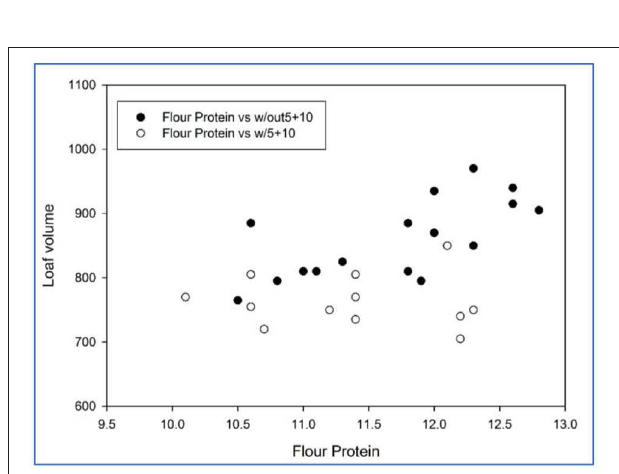
FIGURE 2 | Bread loaf volume of soft durum lines with or without Dx5 + Dy10 (flour protein in percent, loaf volume in cm 3